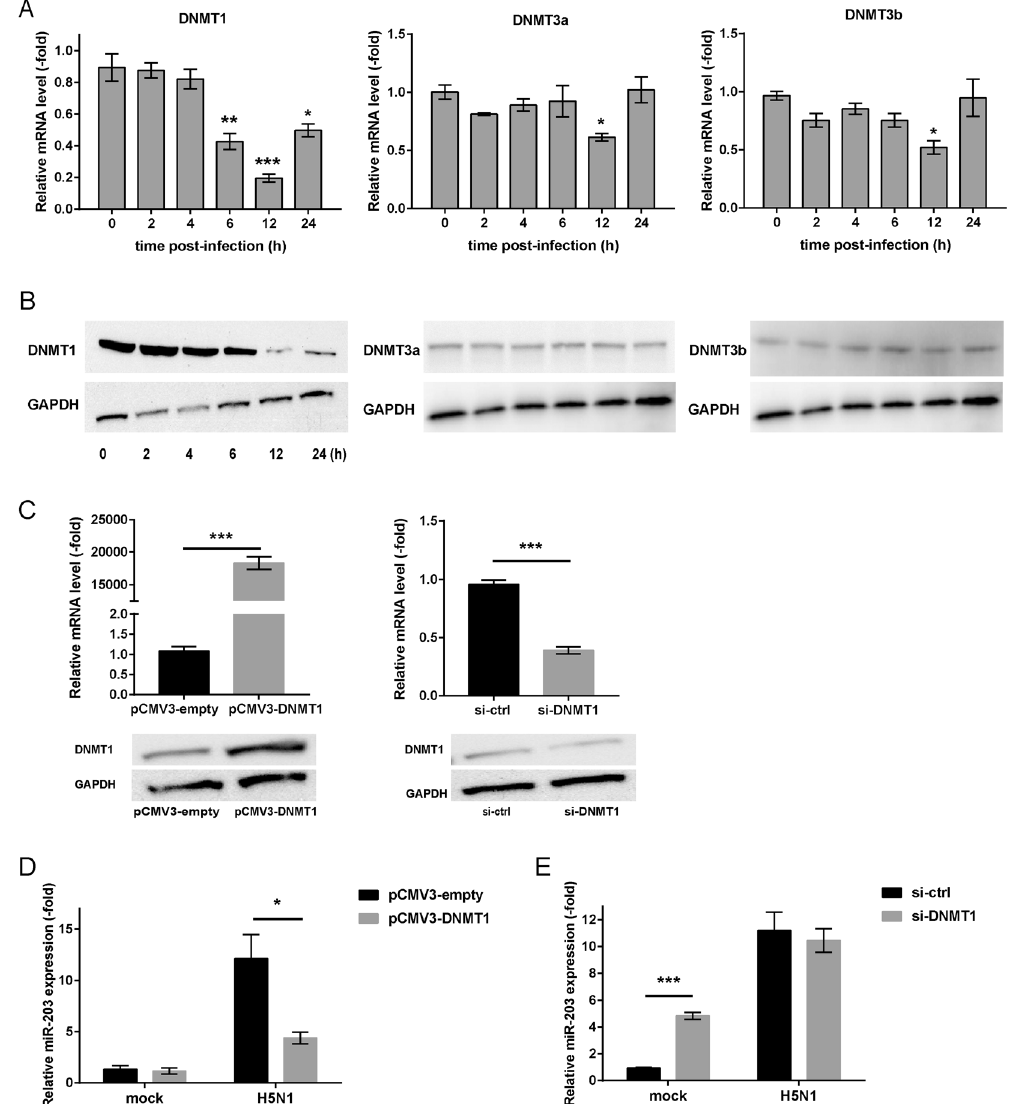
Figure 4. Influenza A virus (IAV) infection inhibits expression of DNA methyltransferase 1 (DNMT1), resulting in up-regulation of miR-203. ( A ) A549 cells were infected with H5N1 (multiplicity of infection (MOI) = 2) viruses, and abundance of mRNAs encoding three DNA methyltransferases (DNMT1, DNMT3a, and DNMT3b) was measured at different times (0, 2, 4, 6, 12, and 24 h). ( B ) Expression of DNMT1, DNMT3a, and DNMT3b protein in A549 cells during H5N1 (MOI = 2) infection was assayed by western blotting. Full-length blots are presented in Supplementary Figures S2–S4. ( C ) A549 cells were transfected for 24 h with pCMV3-DNMT1 or DNMT1-specific siRNA (si-DNMT1). Expression of DNMT1 (pCMV3-DNMT1) and efficiency of si-DNMT1 was measured by qPCR and western blotting. Full-length blots are presented in Supplementary Figure S5. ( D and E ) A549 cells were transfected for 24 h with the pCMV3-DNMT1 plasmid ( D ) or si-DNMT1 ( E ). Next, cells were mock-infected or infected with H5N1 (MOI = 2) viruses for another 24 h to detect abundance of miR-203. The empty vector (pCMV3-empty) and si-control served as negative controls. Data are expressed as the mean + SD of three independent experiments. * p < 0.05; ** p < 0.01; and *** p < 0.001 (Student’s t